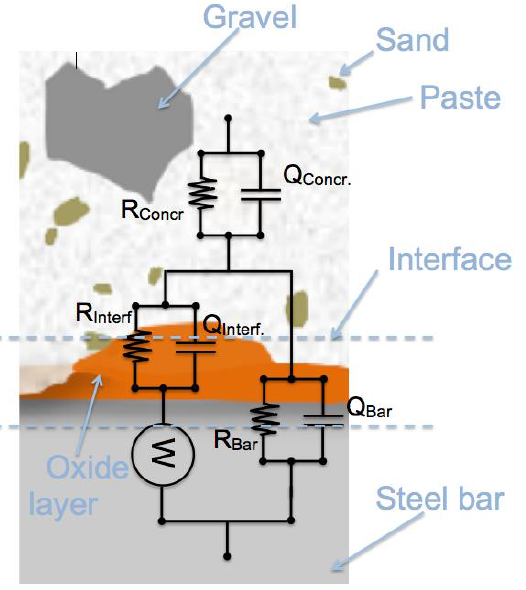
Figure 8. Proposed equivalent circuit (EC) utilized to simulate the EIS parameters.